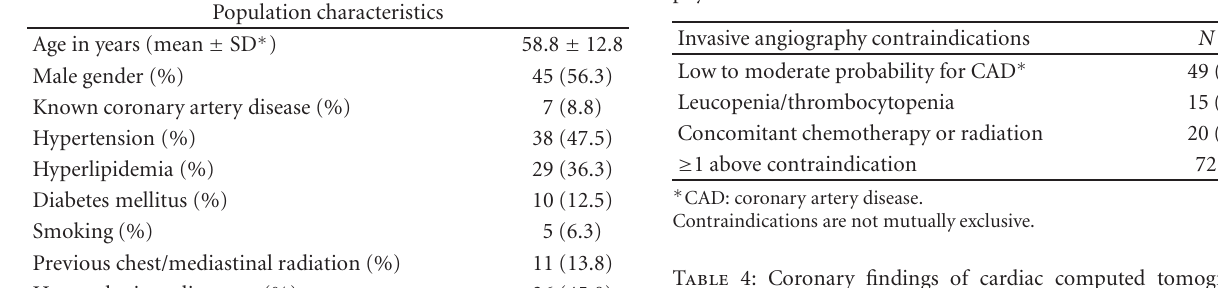
Table 3: Relative contraindications for invasive coronary angiogra- phy.